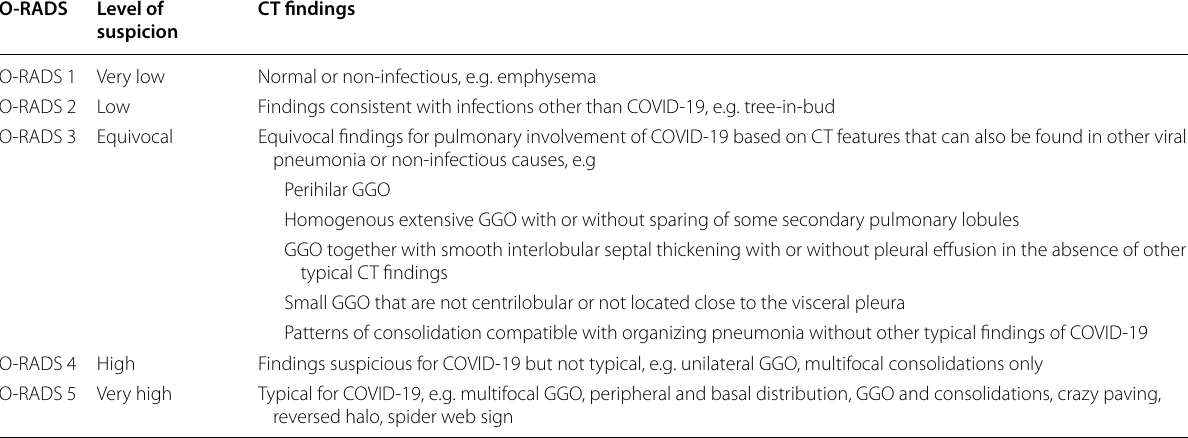
CO-RADS COVID‑19 Reporting and Data System, CT computed tomography, COVID-19 coronavirus disease 2019, GGO ground‑glass opacities